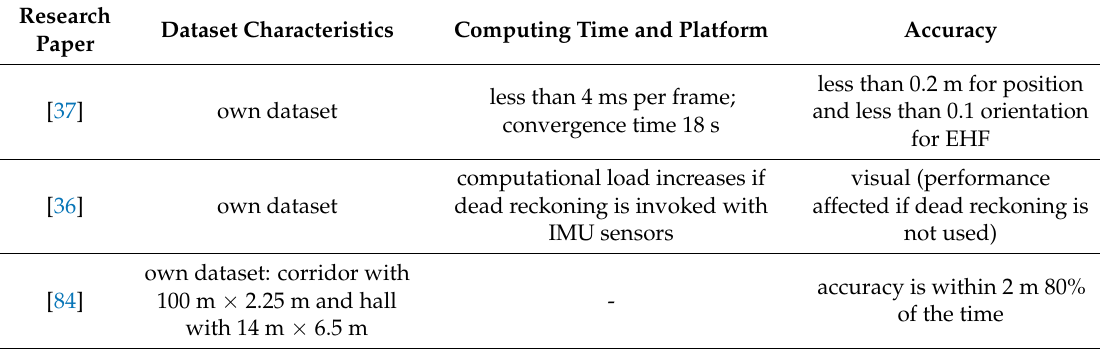
Table 7. Characteristics of indoor localization solutions with 2D cameras + other sensors, markers with known positions, and traditional image